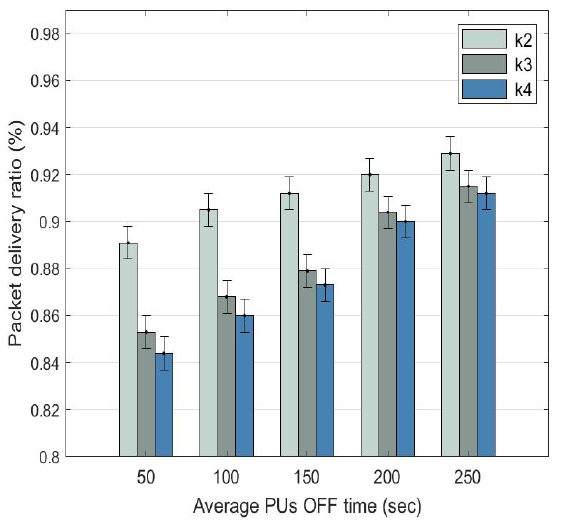
Figure 9. Average packet delivery ratio comparison among D2D routes with dynamic α at different PU OFF